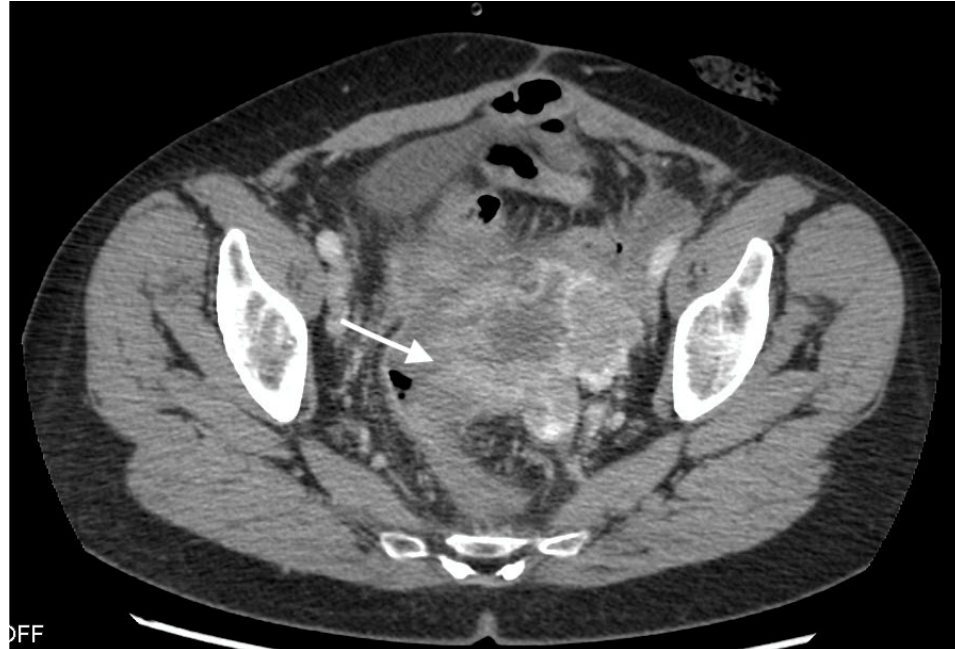
Figure 1. Images from 58-year-old patient with carcinosarcoma of the ovary and recurrence in the rare form of giant cell carcinoma. The fistula between tumor and rectum (arrow), CT post-contrast image in venous phase obtained in the axial plane, shows pelvic tumor and adjacent intestine, fatty tissue between the tumor and intestine vanished as indirect sign of the fistula. fistula was visible on the MR images, showing hypointensity on the T2 and T1 post-contrast